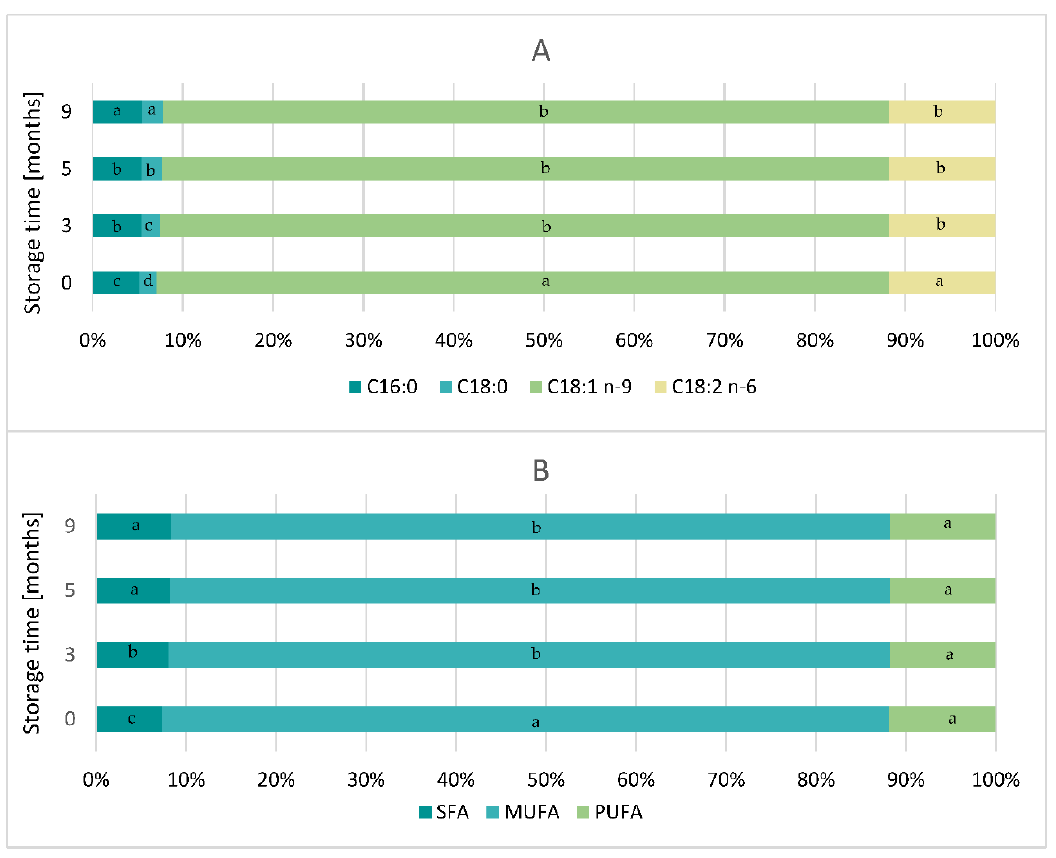
Figure 1. Percentage of main fatty acids( A ) and total SFA, MUFA, and PUFA ( B ) of lipid fractions of hazelnut oil during 9 months of storage (%). Means with different letter (a – d) in the same row were significantly different ( p < 0.05). SFA — saturated fatty acids; MUFA — monounsaturated fatty acid; PUFA — polyunsaturated fatty acid.